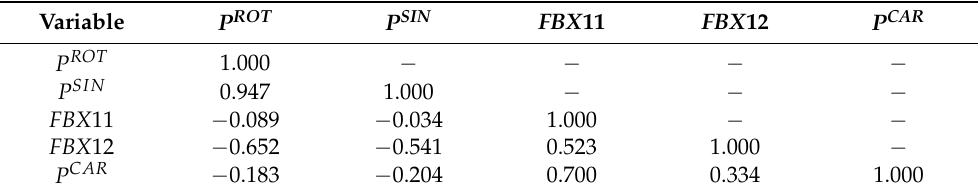
Table 6. Pearson correlations.